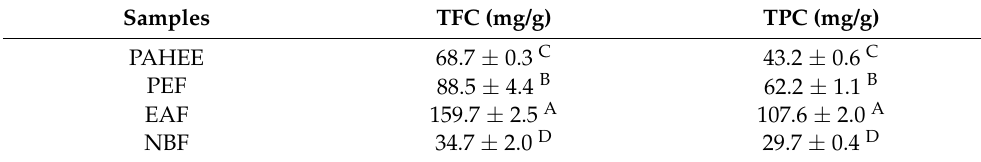
Table 1. Total flavonoids content (TFC) and total phenolics content (TPC) of PAHEE and its